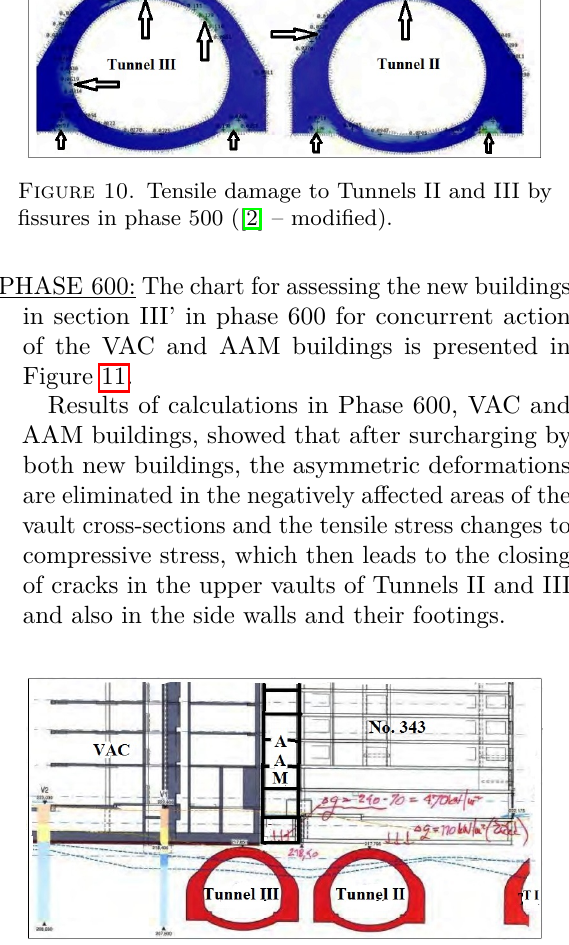
Figure 11. New construction in section III’ – Phase 600 the VAC and AAM Buildings